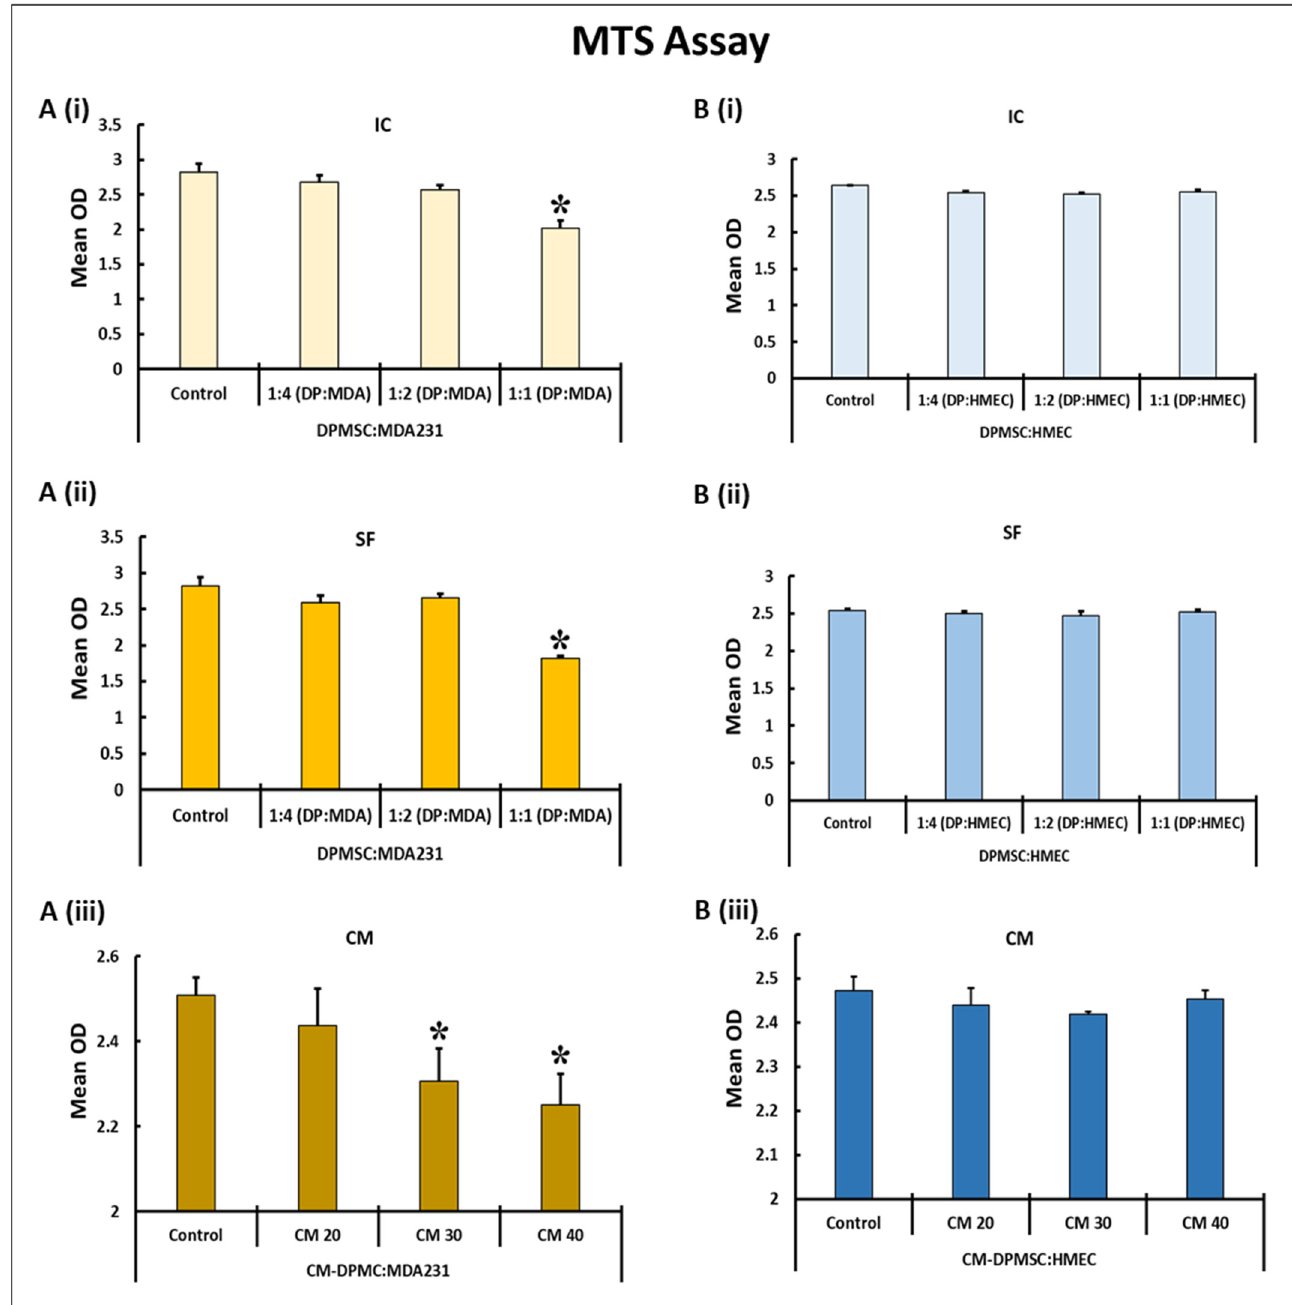
Figure 1. Dose curve of DPMSCs and CM for treatment of MDA231 cells and HMECs: The effect on MDA231 cells ( A ) and HMECs ( B ) in response to different ratios of DPMSCs and different concentrations of CM-DPMSCs at 72 h, post-treatment, using an MTS assay system. After treatment, the proliferation of MDA231 cells did not change in response to the ratios of 1:2 and 1:4 pertaining to DPMSCs to MDA231 cells, as compared to untreated controls. At a 1:1 ratio MDA231 cell proliferation reduced significantly in the IC setting ( A ( i )) as well as in the SF setting ( A ( ii )) as compared to untreated control groups. MDA231 cells demonstrated a significant reduction in growth rate when treated with CM at 30% as well as at 40% concentration as compared to 20% CM treatment and the untreated control ( A ( iii )). In comparison, DPMSCs did not have any effect on HMEC cell proliferation in the IC ( B ( i )) or SF ( B ( ii )) settings as well as at various concentrations of CM of DPMSCs tested ( B ( iii )). IC: intracellular contact; SF: soluble factors; and CM: conditioned media. Mean OD is the mean of absorbance obtained from three individual experiments. Bars represent standard errors. * p <